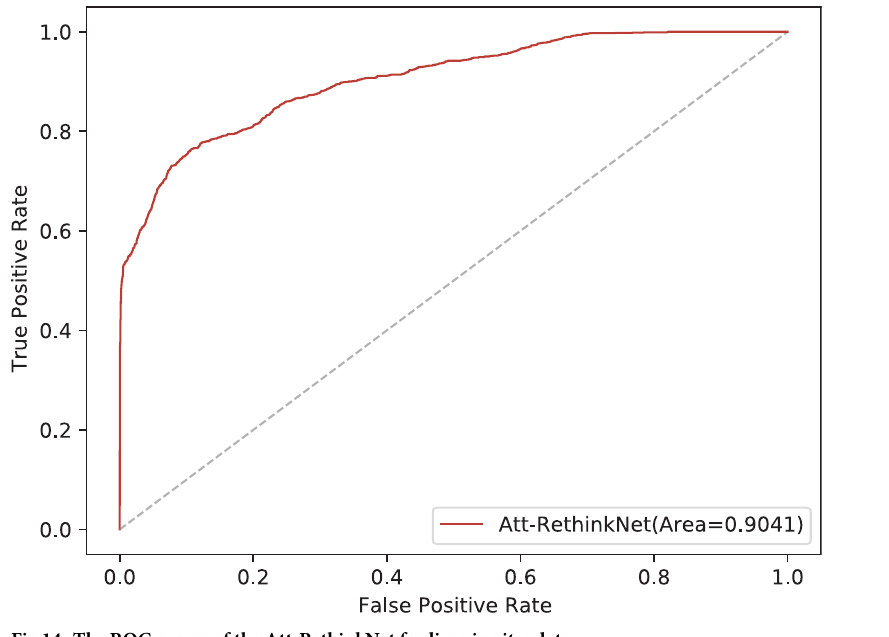
Fig 14. The ROC curves of the Att-RethinkNet for liver in vitro